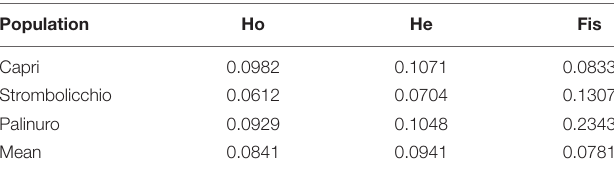
TABLE 2 | Estimates of genetic diversity parameters over 25 individuals (SNPs present in at least 95% individuals) implemented with function basic.stats in the hierfstat R